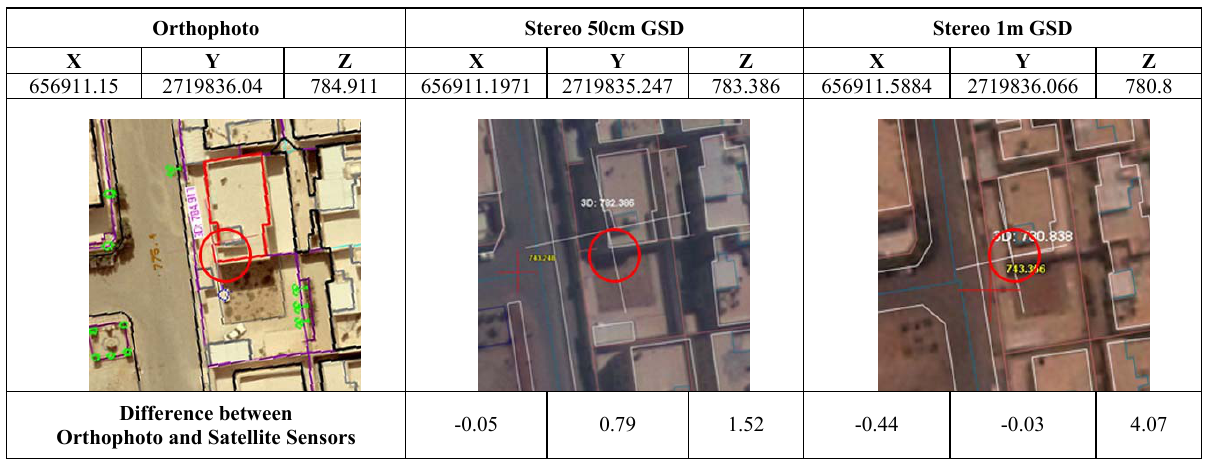
Table 1j. Showing capturing of building corner based on different resolutions of Stereopairs. Comparative Analyses of 50cm GSD and 1m GSD Stereo Satellite Imagery with Orthophoto